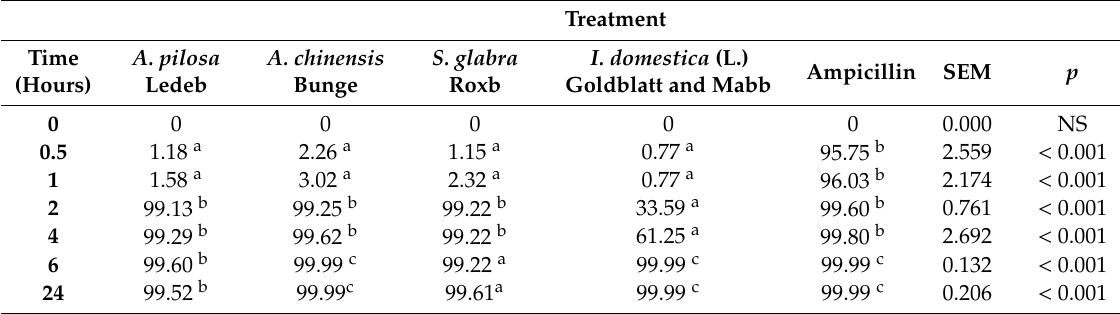
Table 5. Average percentage kill of Salmonrlla enteritidis NCTC 0074, QA0419, LE103, and 1F6144 in the presence of 4 × minimum inhibitory concentration (MIC) of plant extracts and ampicillin over 24